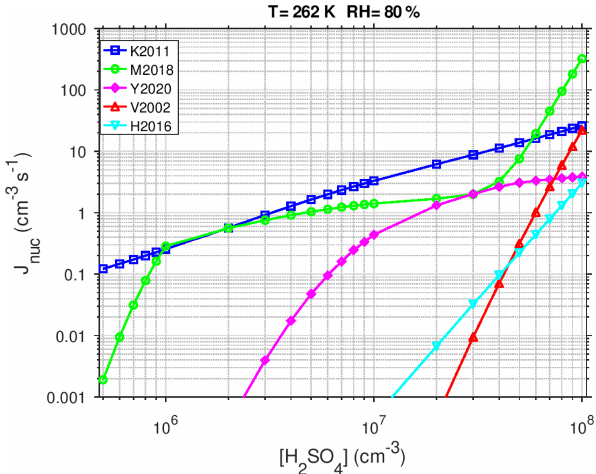
Figure 2. Predicted nucleation rate J nuc (cm − 3 s − 1 ) as a func- tion of the concentration of H 2 SO 4 (at T = 262K and RH = 80%) calculated with different parameterizations for particle formation through sulfuric acid: combined activation and IMN (K2011), neu- tral and ion-induced BHN (M2018), TIMN at NH 3 = 1 × 10 5 cm − 3 (Y2020), THN at NH 3 = 2 × 10 6 cm − 3 (H2016), and classical BHN